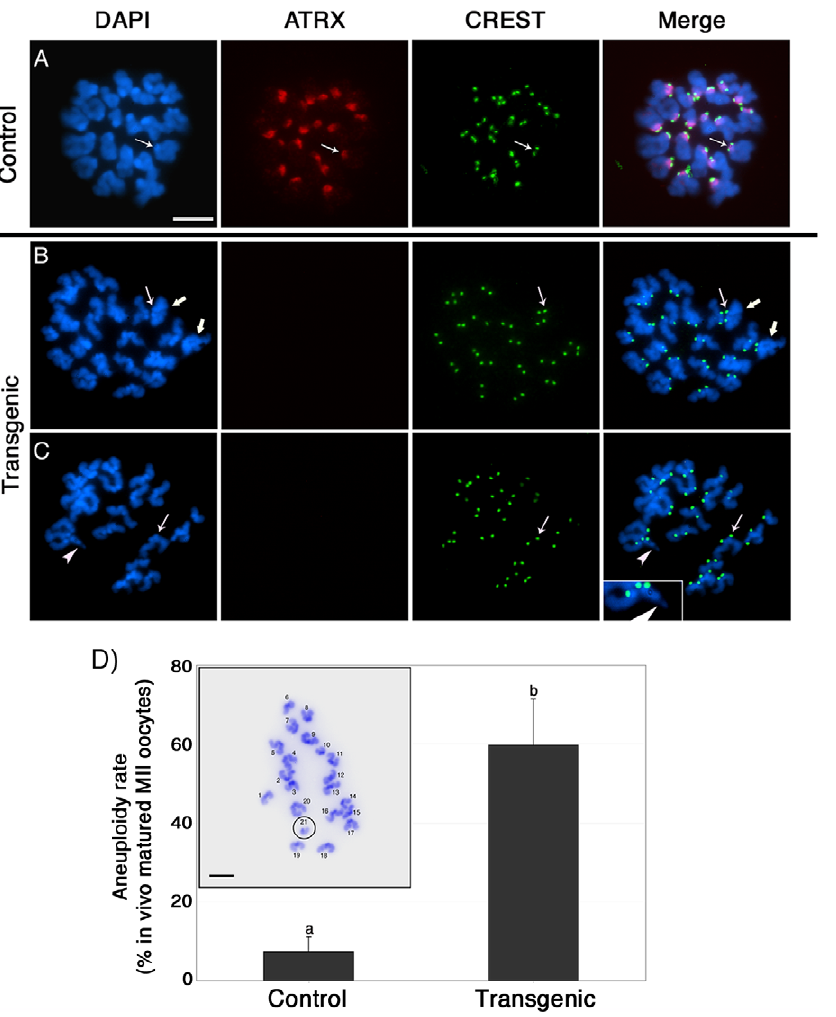
Figure 3. Abnormal chromosome condensation and high incidence of aneuploidy in ATRX deficient oocytes. ( A ) Chromosome spread from a control oocyte at the metaphase II stage showing prominent ATRX staining at pericentric heterochromatin (arrows). ( B ) Lack of ATRX staining at pericentric heterochromatin (thin arrow) is associated with abnormal chromosome condensation (bold arrows) and chromatid breaks ( C , arrowhead). ( D ) In vivo matured transgenic ATRX-RNAi oocytes exhibit a high incidence of aneuploidy. Chromosome spread exhibiting a hyperploid karyotype of 20 chromosomes and an additional single chromatid (circled) is shown. Data are presented as the mean 6 s.d. of three independent experiments. Scale bar =10 m